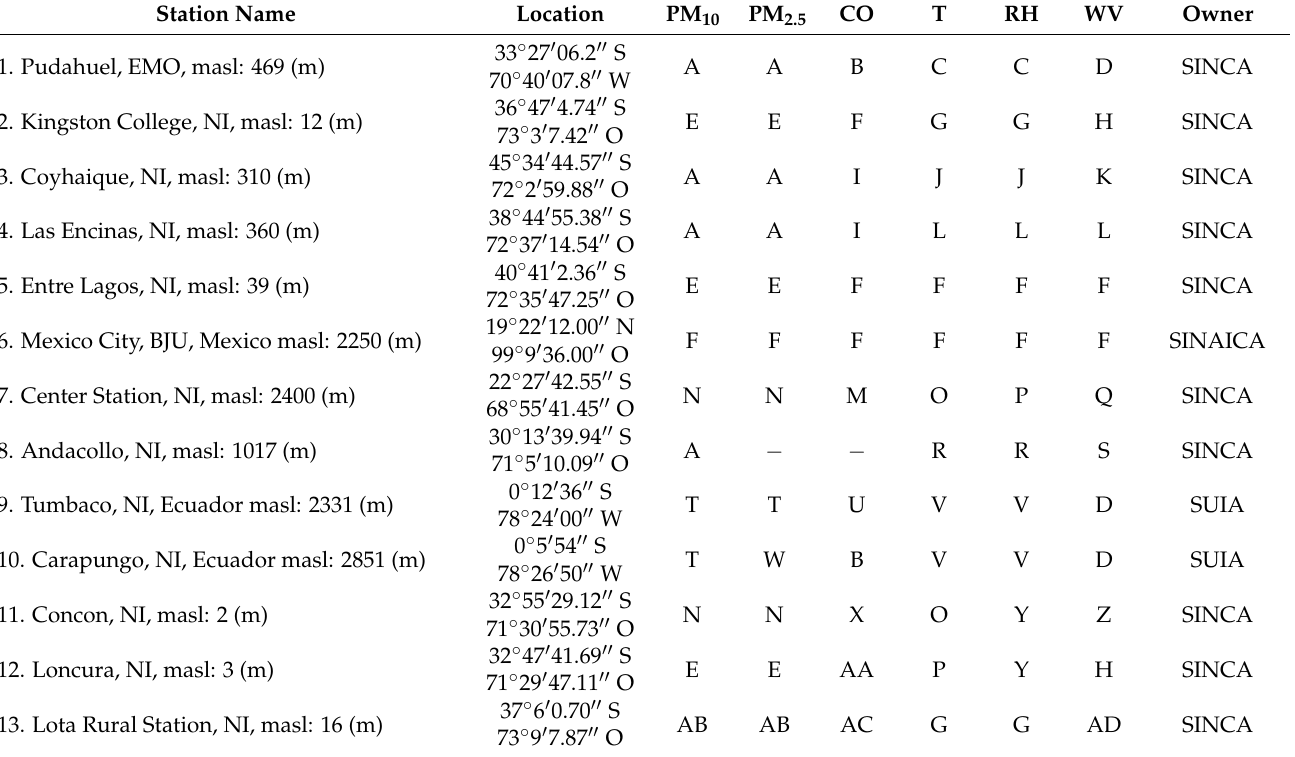
Table 3. Measurement instruments in the 13 locations studied. NI: Without information of the locality code. The capital letters in each box indicate the type of measurement instrument used in the different locations of the study (the meaning of each capital letter with the details of each instrument appears at the end in Abbreviations before the